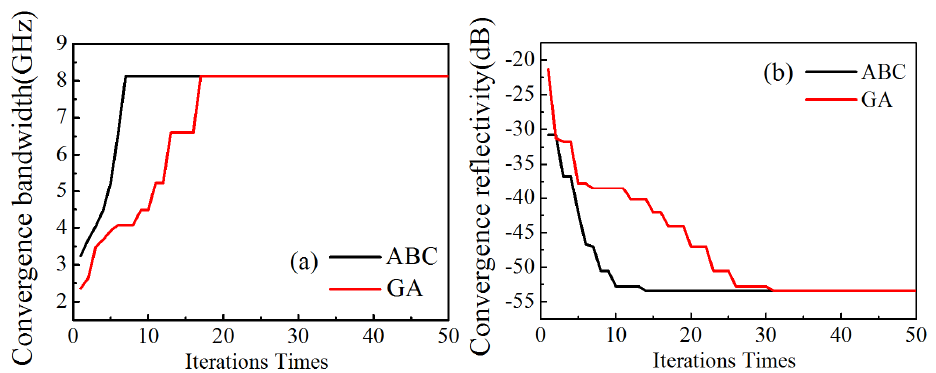
Figure 9. The convergence velocity comparison of two algorithms for the optimal bandwidth ( a ) and reflectivity ( b ) for two-layer materials.